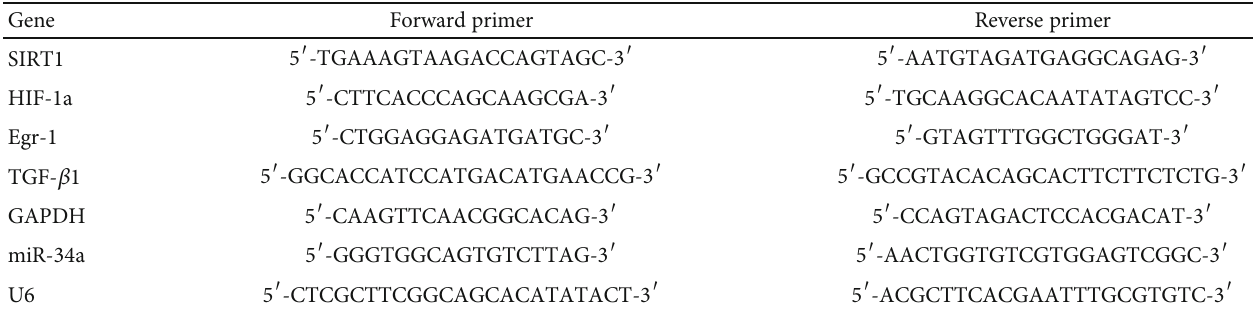
Table 1: Gene sequences of primers.